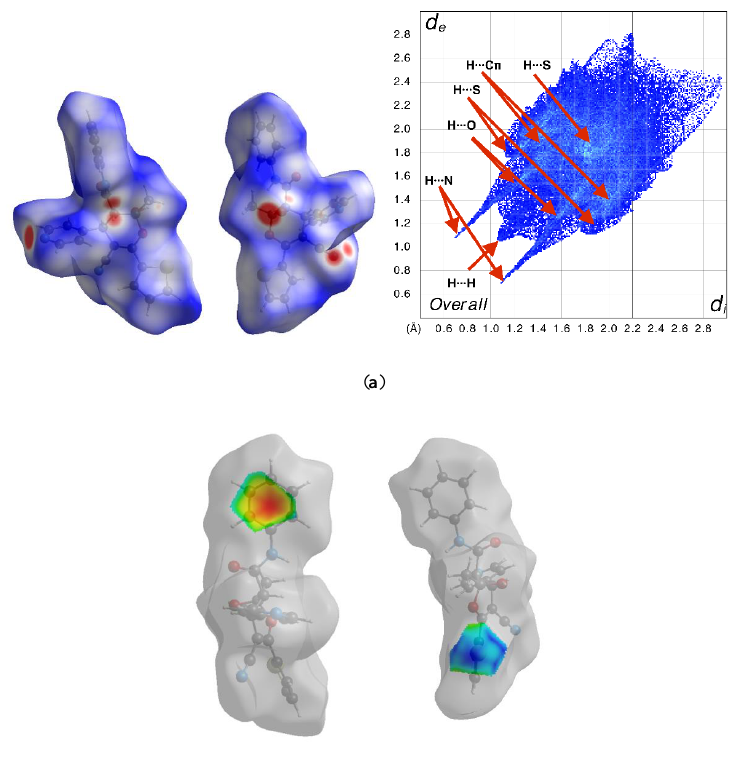
Figure 3. Hirshfeld surface analysis and fingerprint plot ( a ) and, Shape index maps ( b ) showing intermolecular interactions over compound 2 . Molecules 2020 , 25 , x